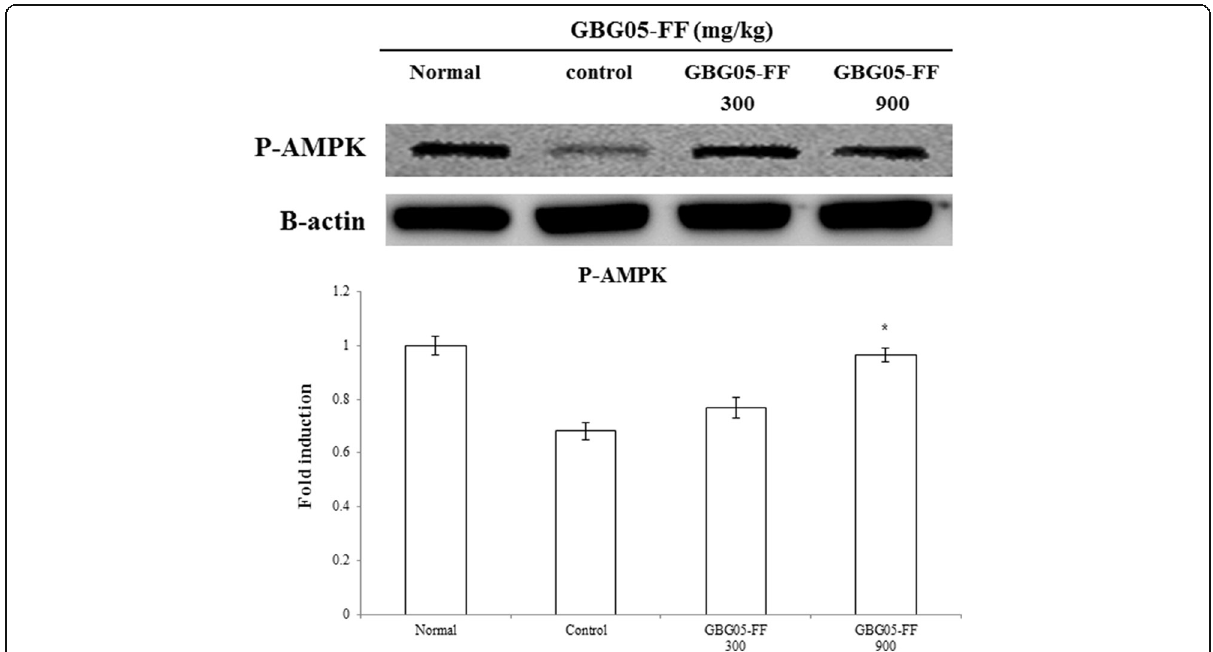
Fig. 6 Effects of GBG05-FF on the phosphorylation of AMPK in livers of mice. Normal: dbh, C2ntrol: db/db, GBG05-FF 300: db/db fed the GBG05-FF 300 mg/kg, and GBG05-FF 900: db/db fed the GBG05-FF 900 mg/kg. Each value represents the mean ± SEM ( n = 10 per group) in three independent